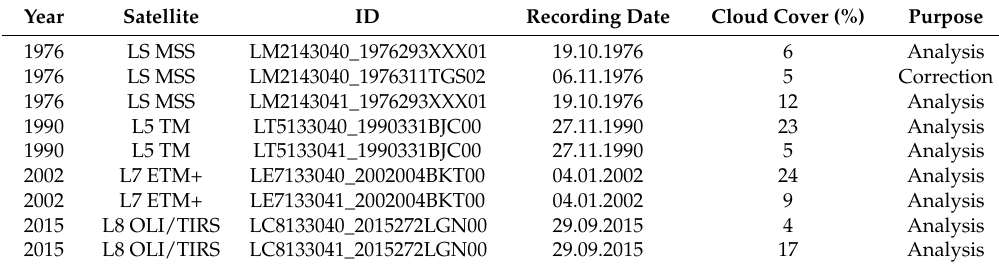
Table 1. Overview of selected Landsat images. Images with cloud cover >10% were suitable for this study because the clouds did not cover the studied glacier areas. The second Landsat image from 06.11.1976 was only used for correction purposes and was not included in the final analysis. Source of all Landsat images is USGS [12].